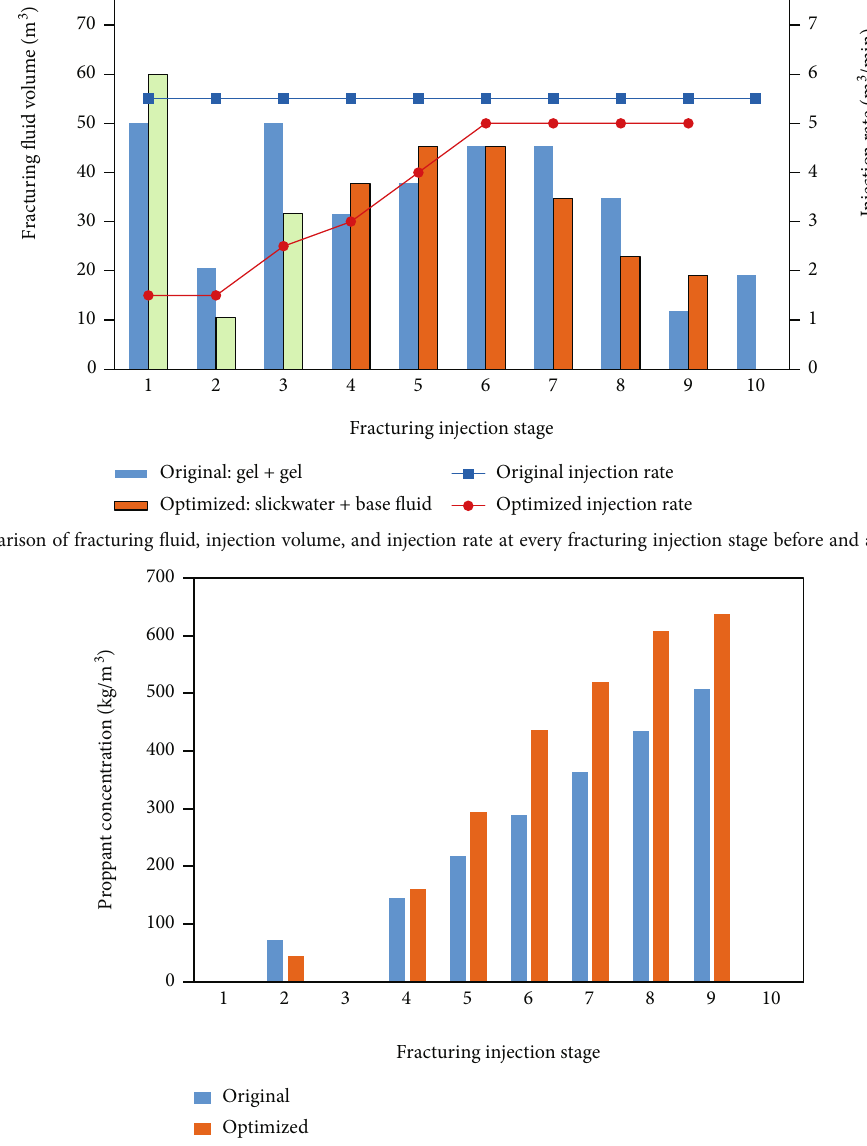
Figure 17: Comparison of original and optimized hydraulic fracturing